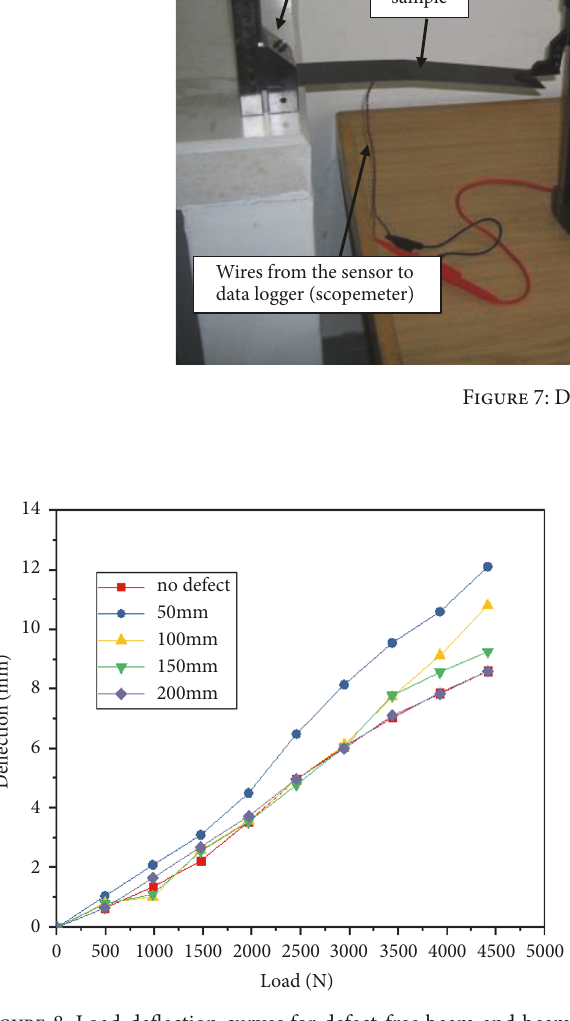
Figure 8: Load-deflection curves for defect-free beam and beams with defects.